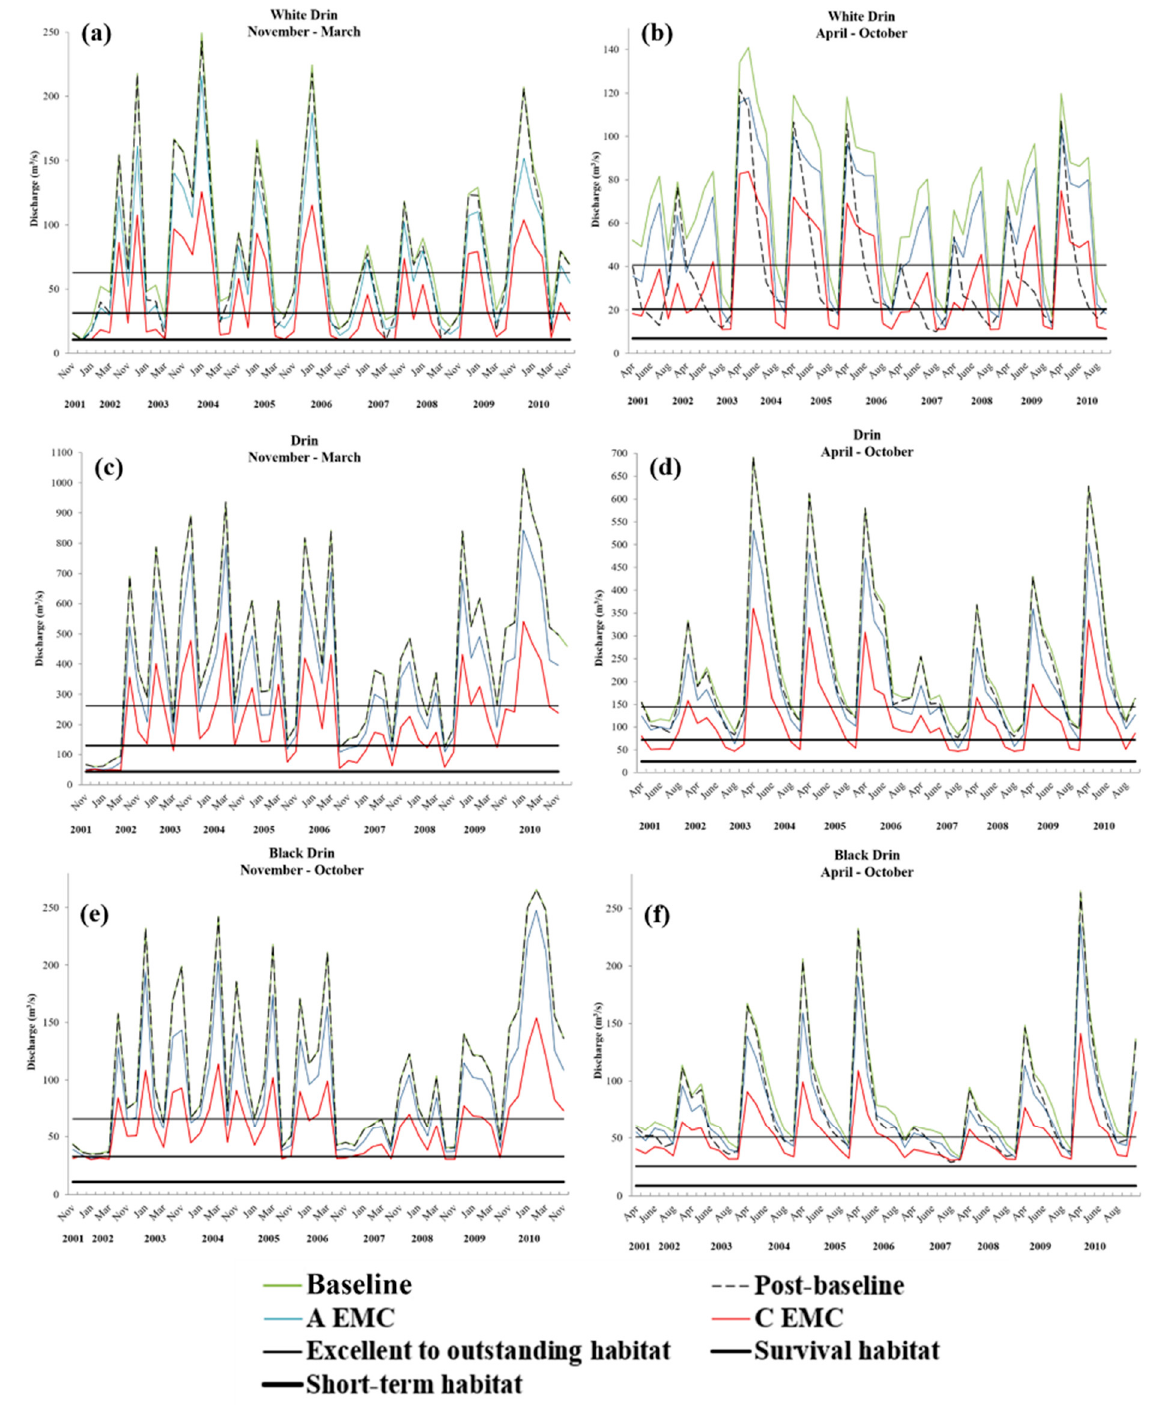
Figure 4. Baseline and post − baseline streamflow, EMCs (A and C), and Tennant method’s thresholds (excellent to outstanding habitat, survival habitat, and short − term habitat) for the three most impacted subbasins of the extended Drin basin (White Drin; ( a , b ), Drin; ( c , d ), and Black Drin; ( e , f )). Descriptive statistics of the simulated daily time series from the E HYPE hydrological model.